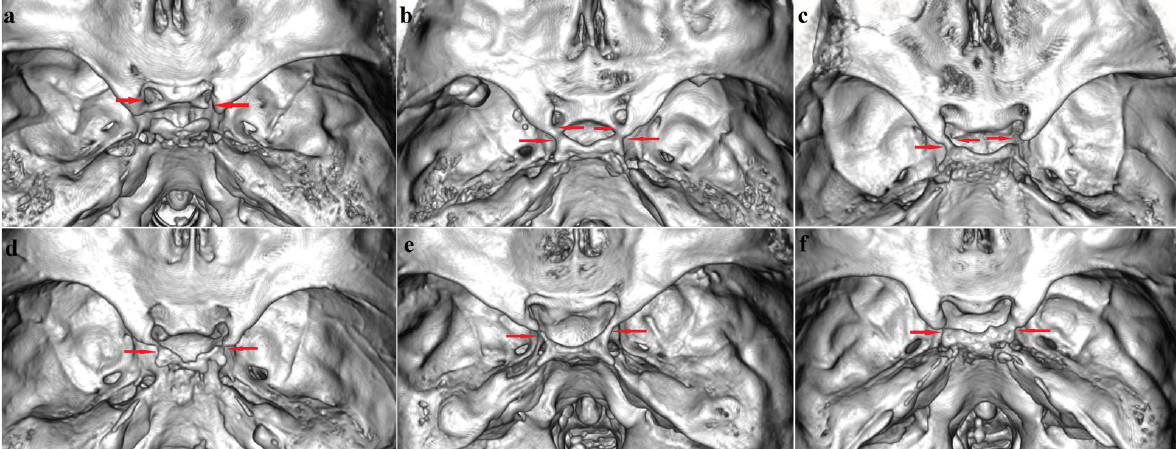
Figure 1. Sellar bridges: ( a ) CcB (Type I): an incomplete CcB on the right side and a complete CcB enclosing CcF on the left side; ( b ) IcB (Type II): a complete form on both sides; ( c ) IcB (Type II) mixed type: an incomplete CcB and IcB on the right side and an incomplete CcB (Type I) on the left side; ( d ) IcB (Type II) mixed type: an incomplete CcB and contact IcB on both sides; ( e ) IcB (Type III): a complete IcB on the right side and an incomplete IcB on the left side; ( f ) IcB (Type III): a complete IcB on the right side and a contact IcB on the left side. Abbreviations: CcB—caroticloclinoid bridge, CcF—caroticoclinoid foramen; IcB—interclinoid bridge. Designations: red arrows point to the osseous bridges (complete and incomplete ones). In the investigated sample the total frequency of IcB - Types II and III was 7.4% (9.1% in males and 5.7% in females). The incidence of complete IcB - Types II and III (including the complete, contact and mixed types) was 5.7% (7.1% in males and 4.5% in females). The incidence of incomplete IcB - Types II and III was 1.6% (2.0% in males and 1.2 in fe- males) (Table 1). The complete and contact forms of IcB Type II represented 40.0% (53.3% in males and 26.7% in females) of all IcB Type II cases; the incomplete IcB Type II was 6.7% (absent in males and in 13.3% of females), and the mixed form was 53.3% (46.7% in males and 60.0% in females). The complete and contact forms of IcB Type III together were equally distributed with the incomplete form of IcB and were found in 50.0% (50.0% in males and 50.0% in females). Table 1. Frequency of sellar bridges by types in both sides and sexes.